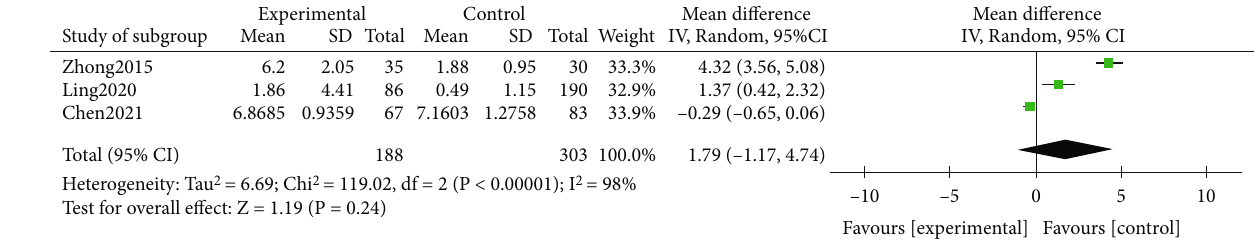
Figure 7: Estimated SMD summary for D-dimer.